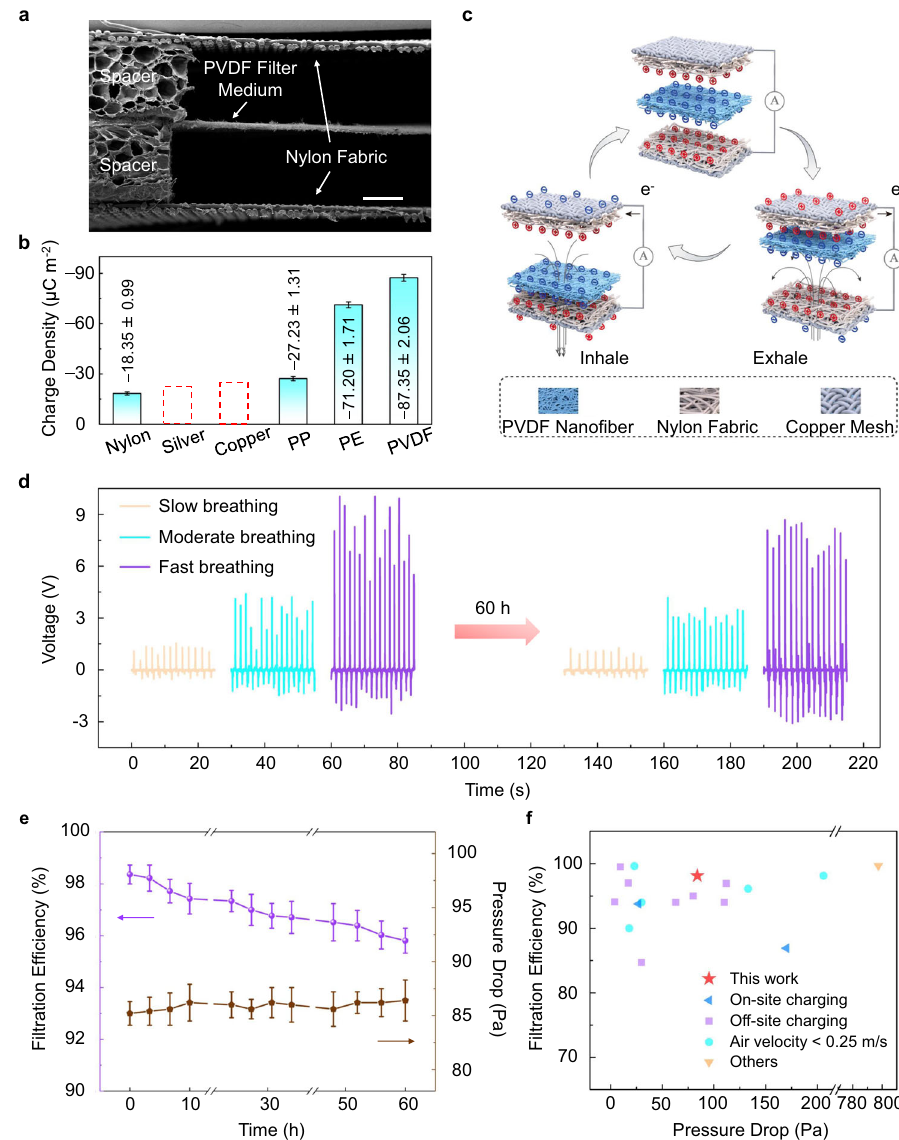
Fig. 4 | Triboelectriceffect-enabled ef fi cientand durablePM fi ltration. a Cross- sectional SEM image of the SAF. Scale bar: 500 μ m. b Triboelectric series com- paring the charge transfer capacity of studied materials 40 . Dashed bars represent qualitative ranking. c Triboelectric charge-generation mechanism of the SAF. d Charge stability test over 60hours. e Durability evaluation of the fi ltration